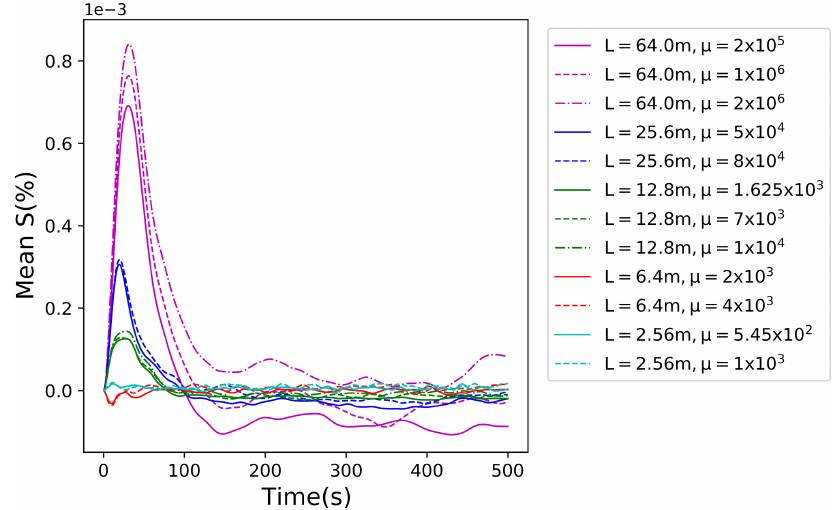
Figure 6. Evolution of the mean supersaturation for various scaled-up domains. Colors represent different domain sizes; different line styles correspond to different multiplicities. The additional simulation of 10 super-droplets per grid volume is only shown for 12 . 8 3 and 64 . 0 3 m 3 volumes.